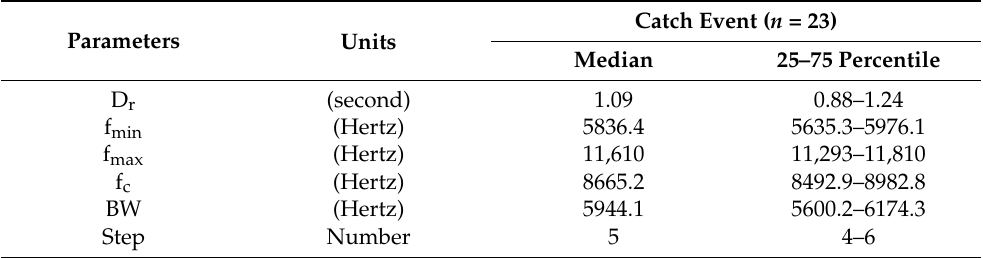
Figure 2. Spectrograms (FFT size 2048-point, Hann window, linear frequency scale) of upsweep whistles of T. truncatus recorded during the bycatch event. ( A ) A sequence of two upsweeps. ( B ) Detail of an upsweep showing the parameters analyzed: D r , total duration; f min , minimum frequency; f max , maximum frequency; f c , central frequency; BW, bandwidth; Step. The low-frequency bursts are highlighted within the dotted blue rectangle. Table 1. Whistle parameters (median ± 25th–75th percentile), assessed during the catch event ( n = 23): D r , total duration; f max , maximum frequency; f min , minimum frequency; f c , central frequency; BW, bandwidth; Step, number of steps; low frequency signals, presence/absence.